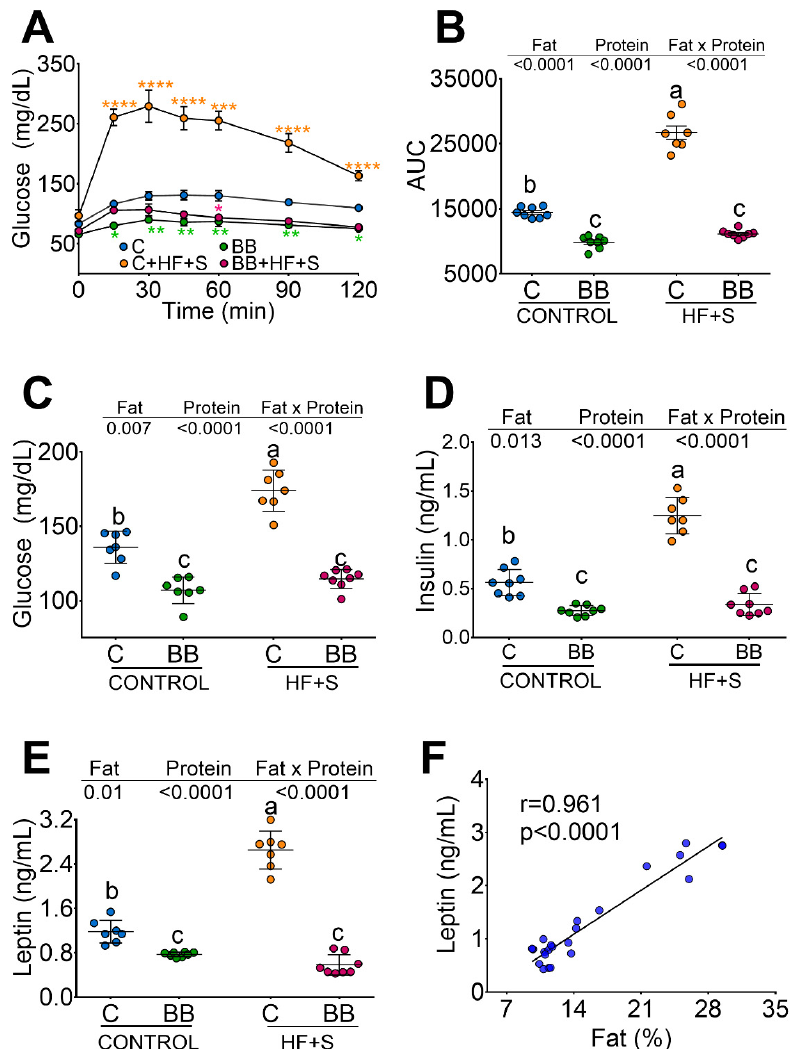
Figure 2. Black bean downregulates leptin and insulin concentration, decreasing glucose intolerance. ( A ) Glucose tolerance test after 2 months of dietary treatment with casein ( C ), black bean (BB), C + high-fat + 5%sucrose (C + HF + S), BB + HF + S. ( B ) Area under the curve (AUC), ( C ) fasting